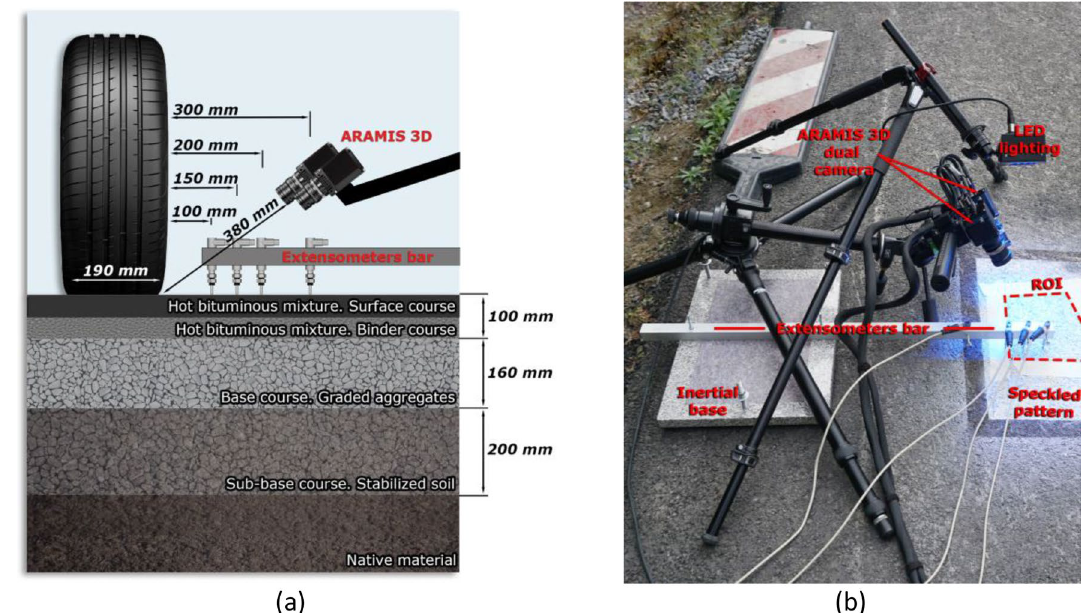
Figure 1. Experimental setup: ( a ) diagram of pavement structure and data acquisition systems, and ( b ) overall setup of the equipment used to monitor the wheel